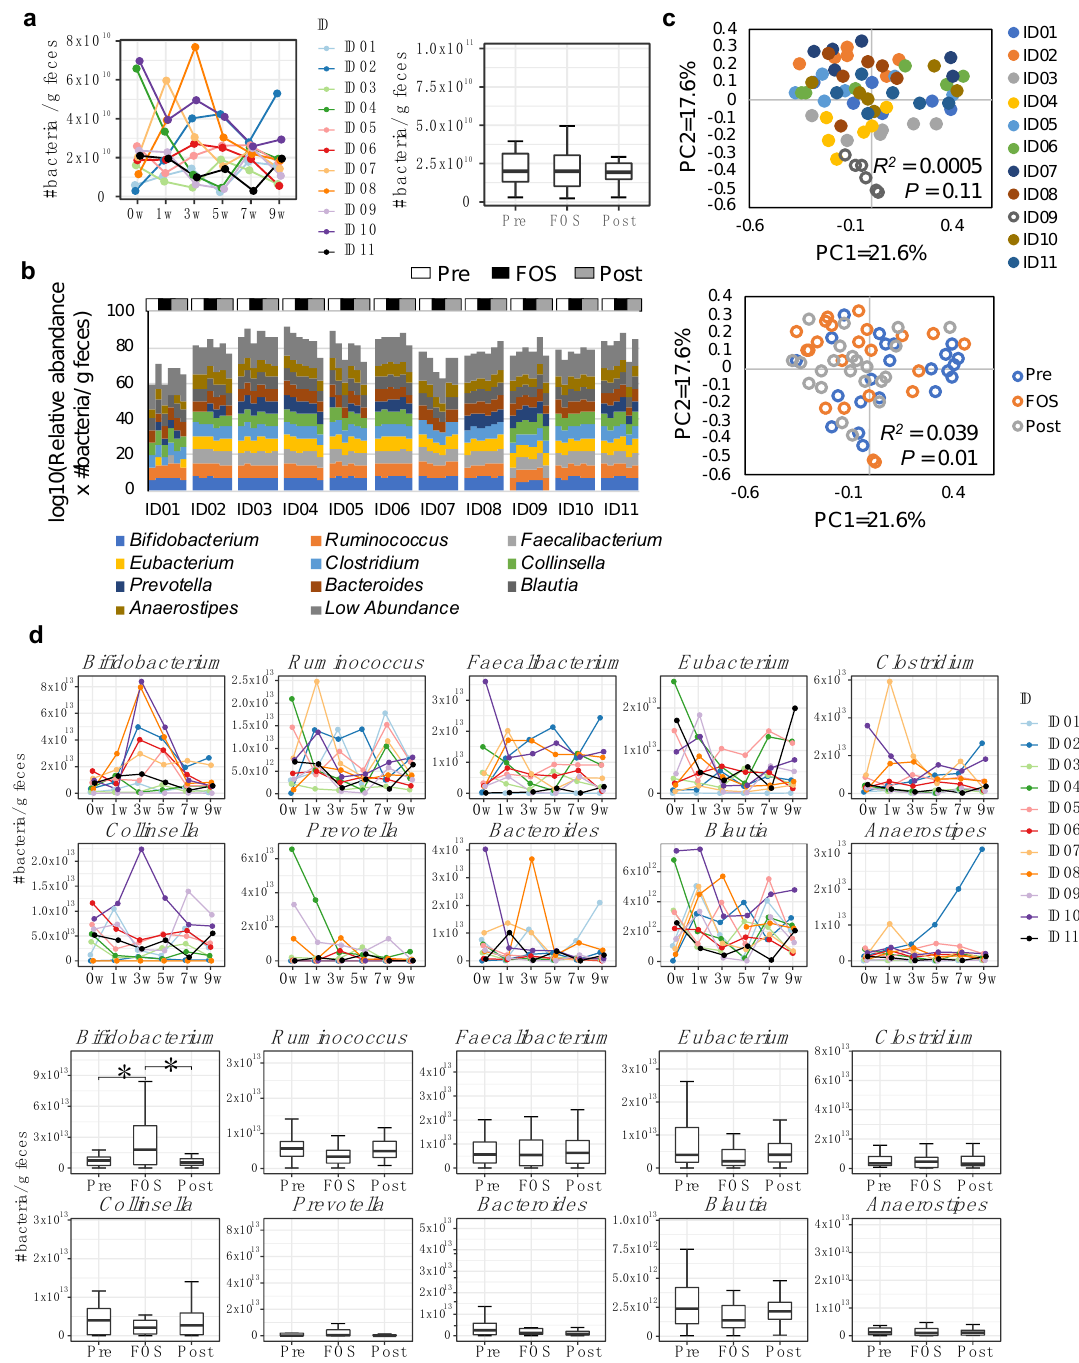
Figure 1. Changes in the total number of bacteria in the fecal microbiota upon FOS supplementation. ( a ) The absolute number of bacteria in each individual by real-time 16S rRNA gene qPCR. ( b ) The composition of microbiota at the genus level in fecal samples using 16S rRNA gene amplicon sequencing. These figures were constructed by the top 10 bacteria at the genus level, respectively. ( c ) PCoA analysis using Bray – Curtis distance of fecal microbiome colored by individuals ( Upper ) and sampling periods ( Lower ). ( d ) The total number of each bacterium in feces at the genus level. The upper figure is illustrated for each individual and the lower figure is summarized for the sample period. * = padj <